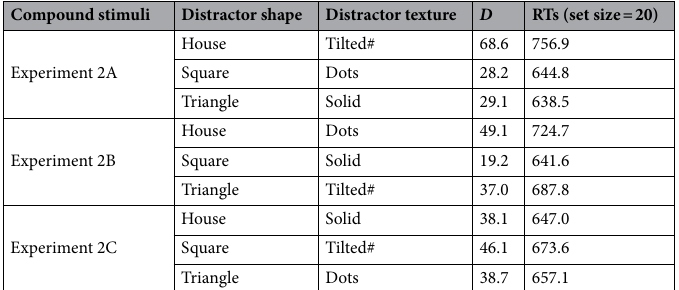
Table 2. Logarithmic search efficiency ( D ) in Experiments 2A–C as well as reaction times (RTs) at set size 20.